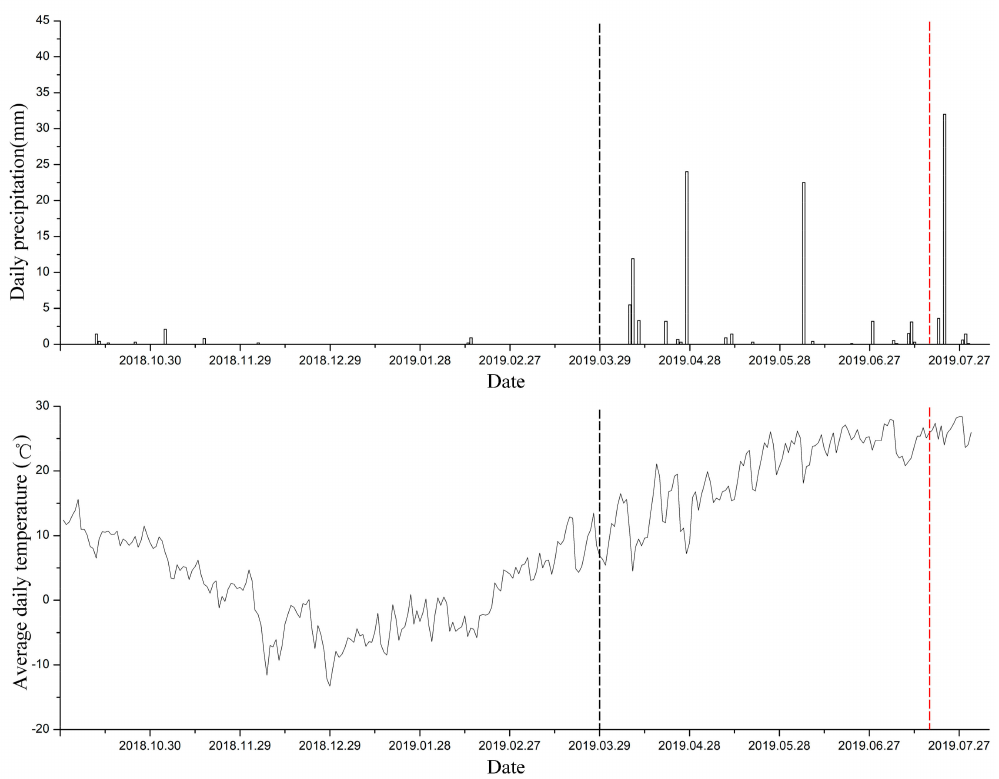
Figure 10. Average daily temperature and daily precipitation data for study site 2 obtained from Taiyuan weather station (longitude: 112.35 ◦ E, latitude: 37.37 ◦ N) during the period from October 2018 to July 2019. There is almost no precipitation from October 2018 to March 2019, and the temperature has continued to rise since January 2019. The location of the black dotted line represents the ignition date of the fire, and the location of the red dotted line represents the time of field